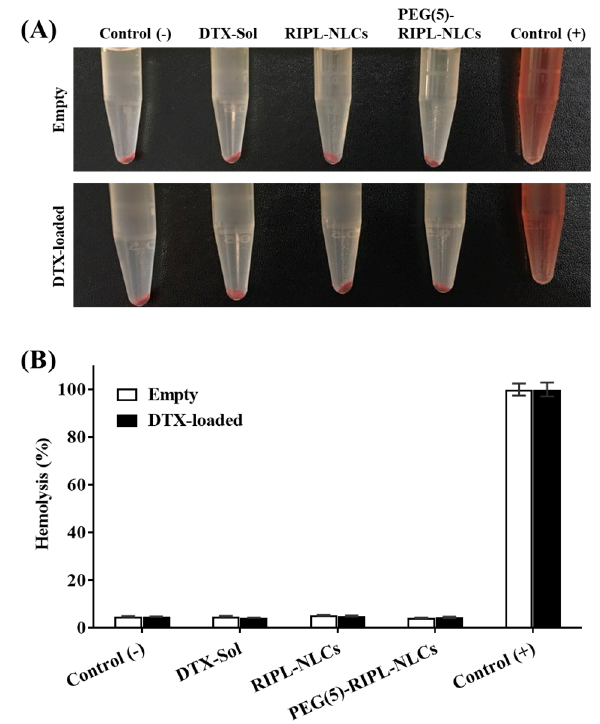
Figure 8. Hemocompatibility of the empty and DTX-loaded formulations with red blood cells (RBCs). ( A ) Photographs of tubes after centrifugation. ( B ) Percentage of hemolysis within 1 h. A saline solution was used as the negative control, and Triton X-100 (1%, v / v ) was added to the positive control. Data are the mean ± SD ( n = 3).